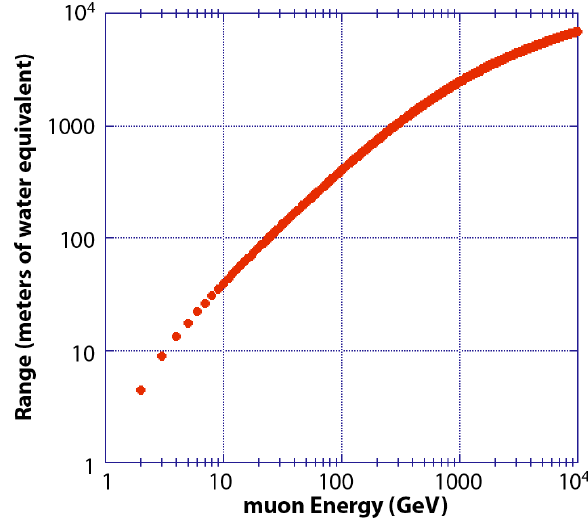
Figure 2: The muon range in standard rock underground on Earth as a function of muon energy, expressed in meters of water equivalent [ Reichenbacher et al, 2007]. The depth accessible to muon radiography depends upon the energy of the muons, the composition of the rock in question, the surface muon flux, target/detector geometry, detector size and efficiency, image resolution and measurement integration time.